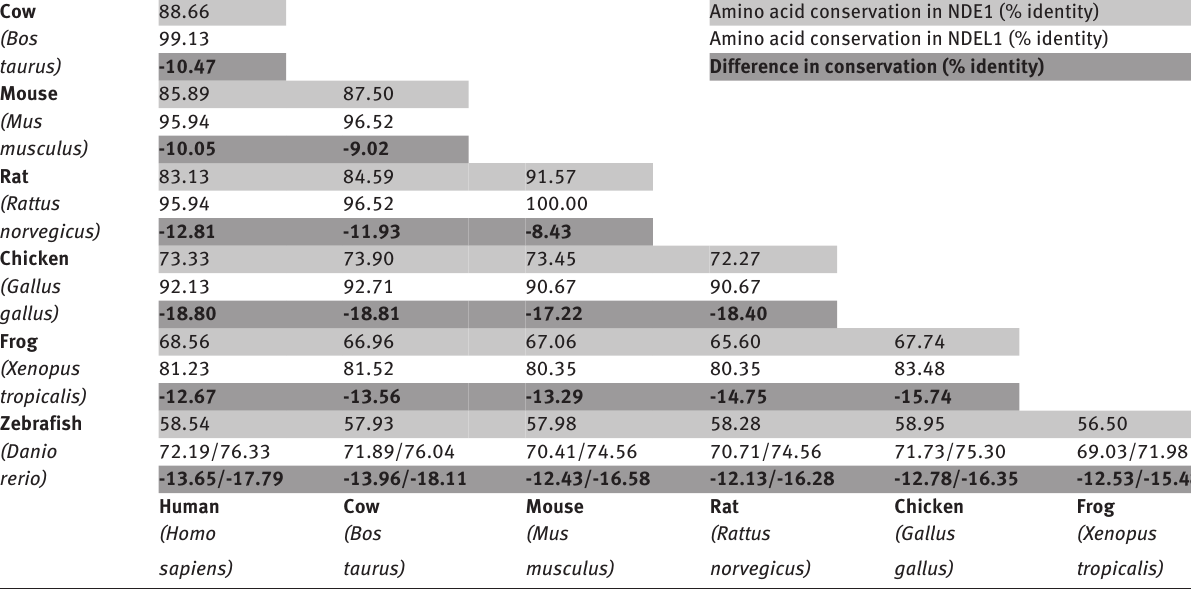
The percentage amino acid sequence identity was compared using Clustal Omega (108, 109) after alignment shown in Figure 1. All-against- all pairwise inter-species percentage identity for NDE1 is shown on the top row on a lighter gray background, and for NDEL1 on the middle row on a white background. The difference between these values is shown on the bottom row in bold type on a darker gray background. As there are two NDEL1 genes in zebrafish (110), values for both encoded proteins are displayed, ndel1a on the left and ndel1b on the right. It can be seen that in every instance, between all species examined, NDEL1 is more highly conserved than NDE1.